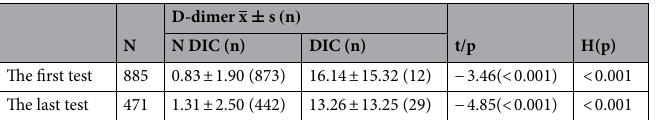
Table 3. Relationship between D-dimer level and disseminated intravascular